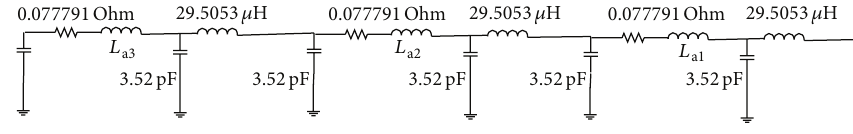
Figure 3: The high-frequency model of each phase.